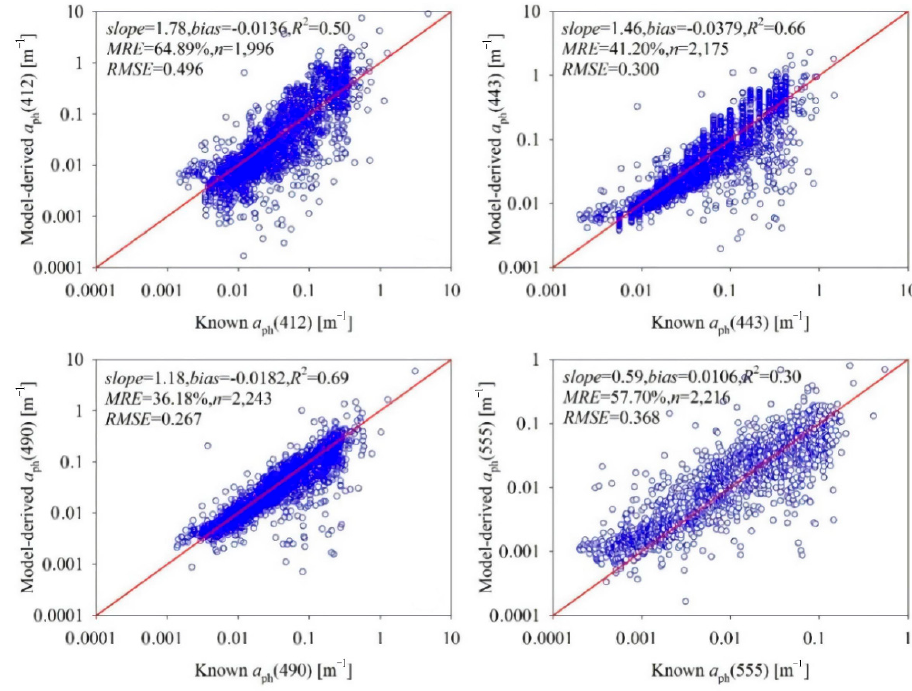
Figure 5. Accuracy evaluation of the TAA model in a ph ( λ ) retrieval in global coastal and marine waters.